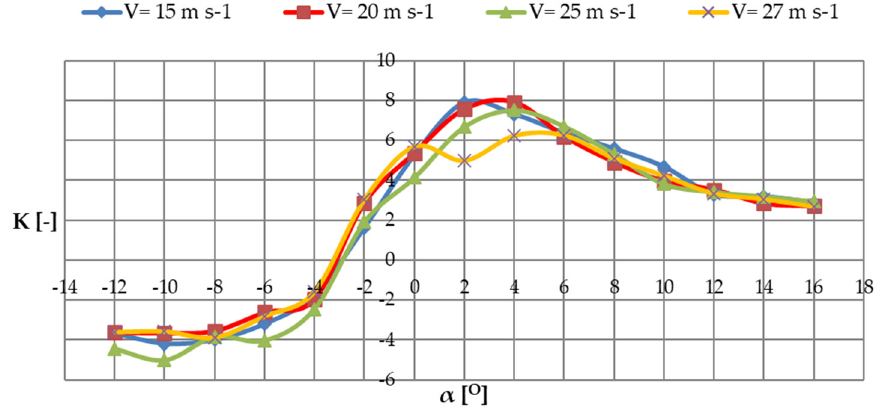
Figure 15. Summary plot of aerodynamic efficiency characteristics, K = Cz/Cx( α ), as a function of the angle of attack α of M-346 model for all tested airflow